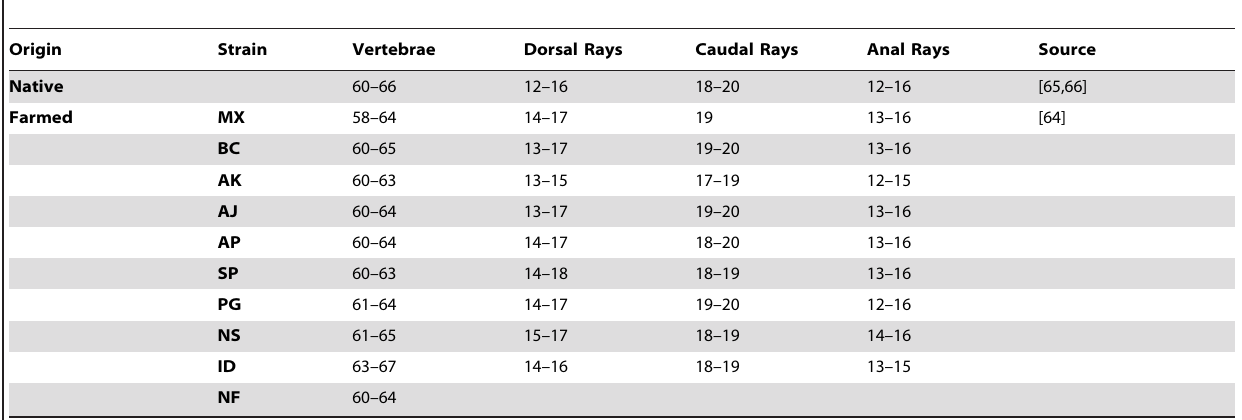
Table 9 . Summary of meristic ranges in previously analysed reared [64] and wild [65,66] rainbow trout. MX: Mexico; BC: Bogota Columbia; AK: Alaska; AJ: S. Africa Jonkershoek; AP: S. Africa Pirie; SP: Spain; PG: Poland; NS: Normandale Spring; ID: Idaho; NF: Normandale